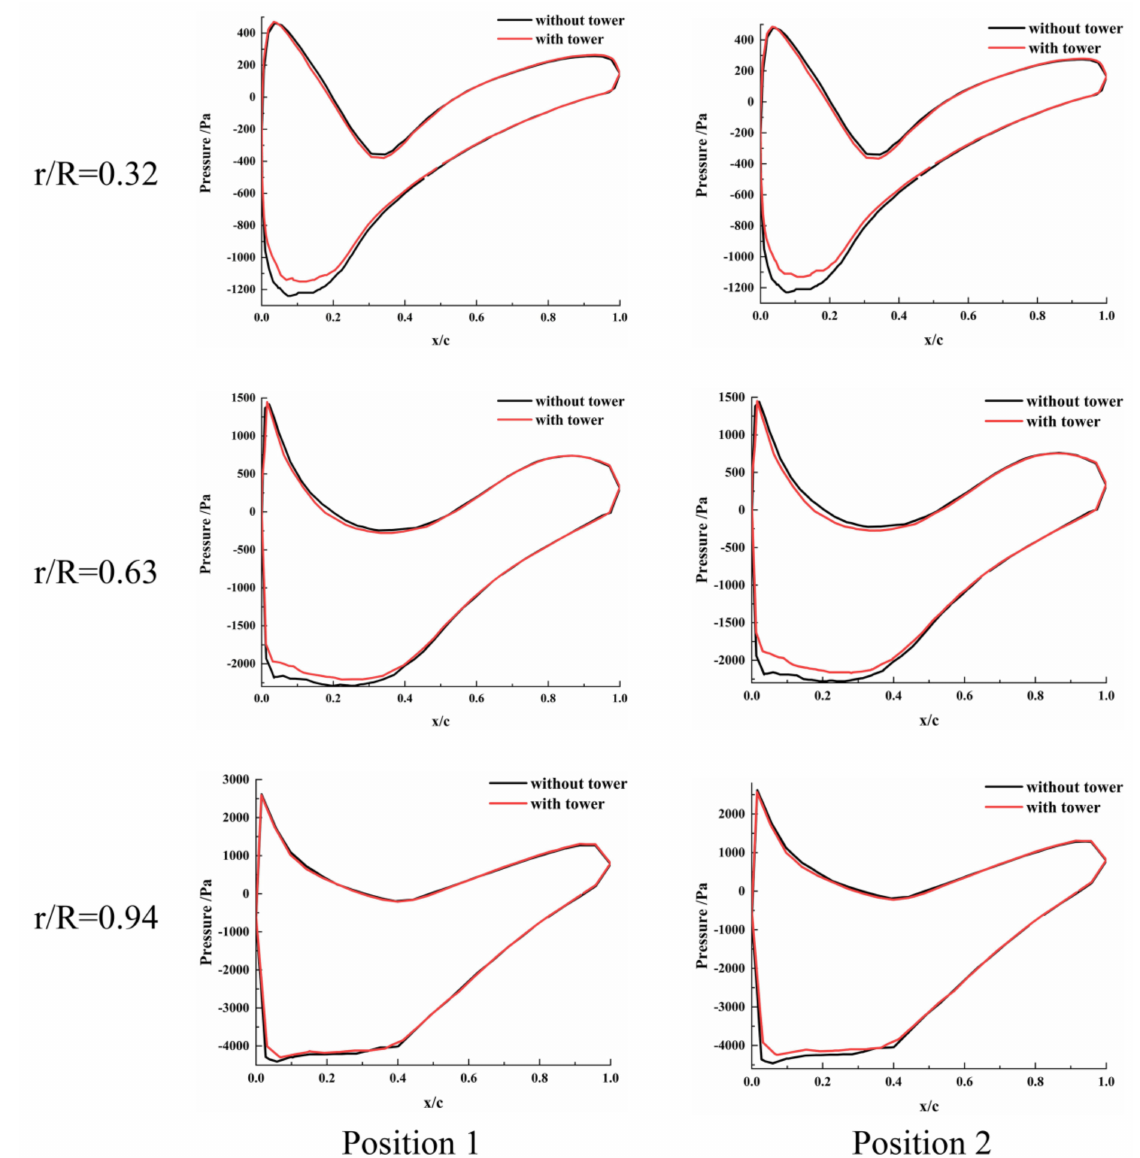
Figure 16. Distribution of pressure in each section of blade at position 1 and position